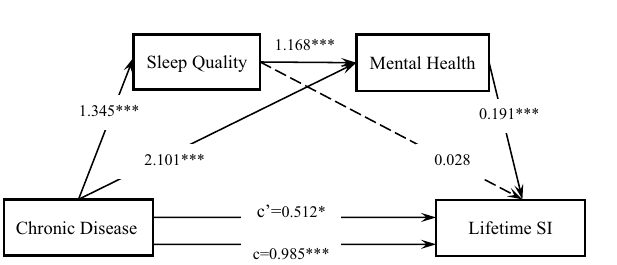
Figure 2. Serial multiple mediation of self-reported sleep quality and mental health in the relationship between chronic disease and lifetime SI. c is the total effect of chronic disease on lifetime SI. c’ is the direct effect of chronic disease on lifetime SI, represented by a dotted line. The other values in the figure are regression coefficients in the model. *p < 0.05, **p < 0.01, ***p < 0.001.